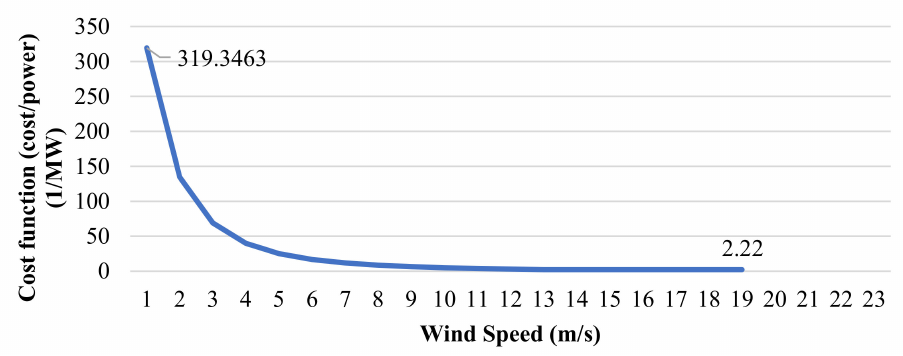
Figure 14. The unit cost of power with different wind speeds.